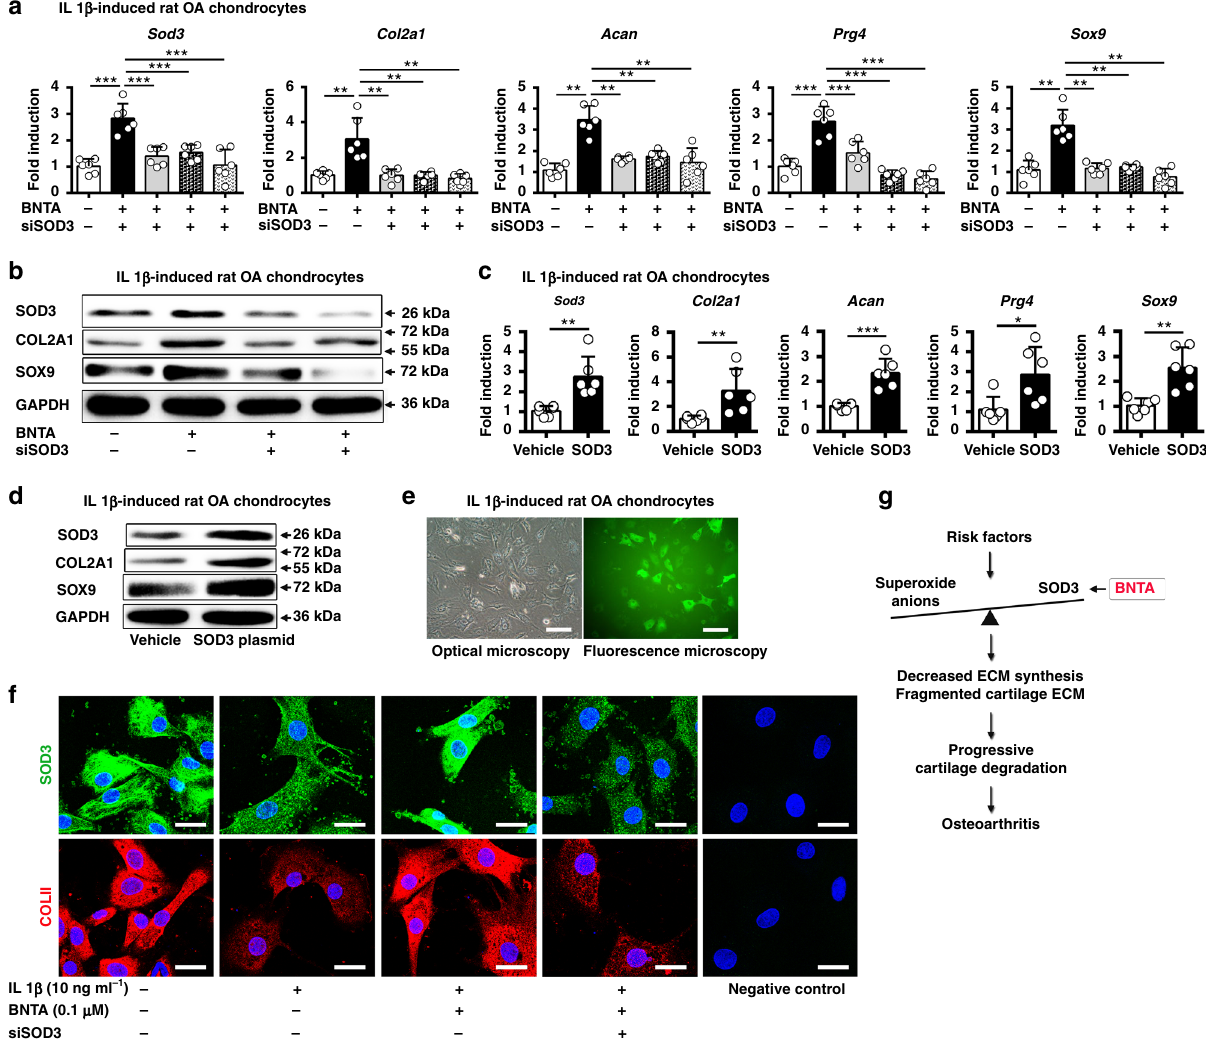
Fig. 7 Identi fi cation of superoxide dismutase 3 (SOD3) as the target of BNTA. a Sod3 , collagen type II alpha 1 chain ( Col2a1 ), aggrecan ( Acan ), proteoglycan 4 ( Prg4 ), and SRY-box 9 ( Sox9 ) mRNA levels in interleukin 1 beta (IL1 β , 10 ng ml − 1 )-induced rat osteoarthritis chondrocytes cultured with BNTA (0.1 μ M) or three siSOD3s for 6 h, respectively ( n = 6 for each group; Sod3 , Prg4 , one-way ANOVA; Col2a1 , Acan , Sox9 , nonparametric test). b The proteins levels of SOD3, COL2A1, SOX9, and glyceraldehyde-3-phosphate dehydrogenase (GAPDH) in IL1 β (10 ng ml − 1 )-induced rat OA chondrocytes treated with BNTA (0.1 μ M) or siSOD3s for 2d. c Sod3 , Col2a1 , Acan , Prg4 , and Sox9 mRNA levels in IL1 β (10 ng ml − 1 )-induced rat OA chondrocytes treated with vehicle or SOD3 plasmid for 2 d ( n = 6 for each group; Sod3 , Acan , and Sox9 , unpaired two-tailed Student ’ s t -test; Col2a1 and Prg4 , nonparametric test). d The proteins levels of SOD3, COL2A1, SOX9, and GAPDH were evaluated in IL1 β (10 ng ml − 1 )-induced rat OA chondrocytes treated with or without SOD3 plasmid for 2 d. e Images of IL1 β -induced rat OA chondrocytes under optical and fl uorescence microscopy after incubation with SOD3 plasmid for 2 d (scale bar, 400 μ m). f Immuno fl uorescence staining for SOD3 and COLII in rat primary chondrocytes cultured with IL1 β (10 ng ml − 1 ), BNTA (0.1 μ M), or siSOD3 for 2 d. Scale bar, 25 μ m. g The working model of how BNTA protects against OA development by activating SOD3. Data are shown as the mean ± standard deviation (s. d.). * P < 0.05, ** P < 0.01, *** P < 0.001. Source data are provided as a Source Data fi